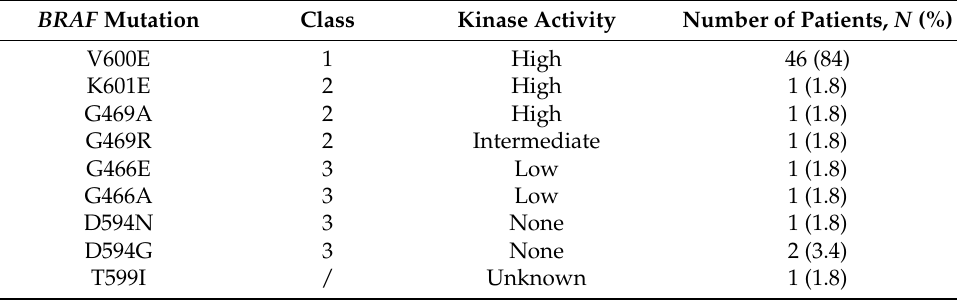
Table 1. Classification of BRAF mutations in patients’